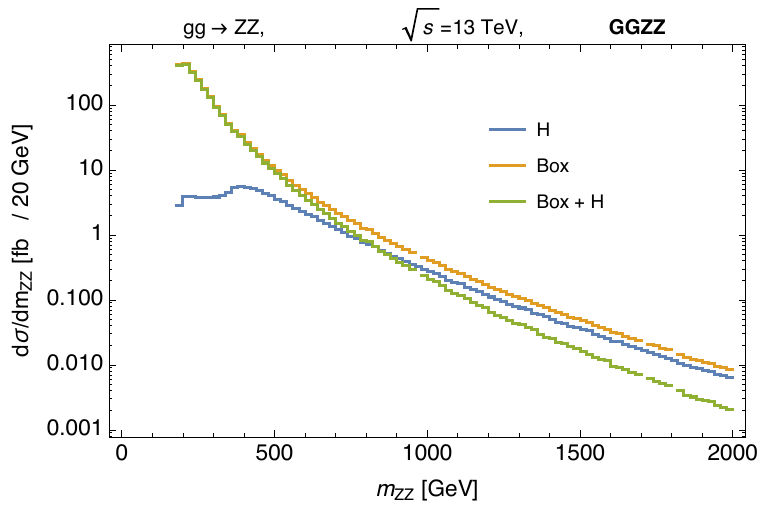
Figure 13. gg ! ZZ . The interference of the Box and Higgs